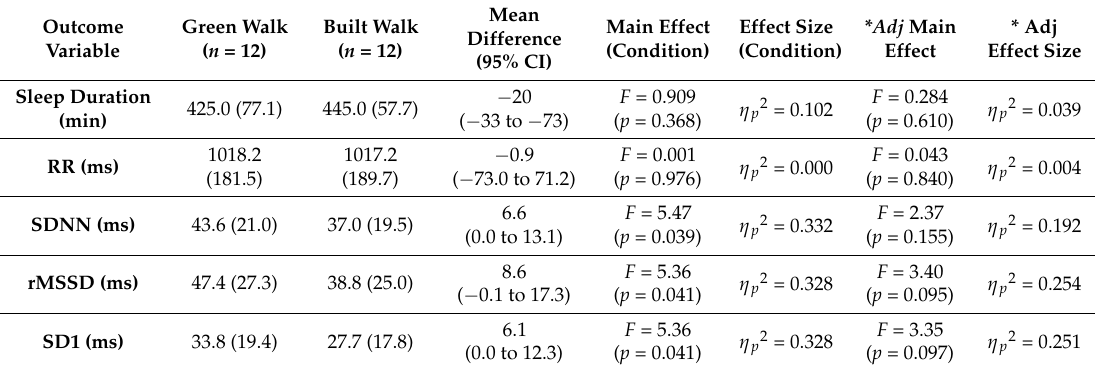
Table 1. Overnight sleep duration and HRV measures following green or built walks.